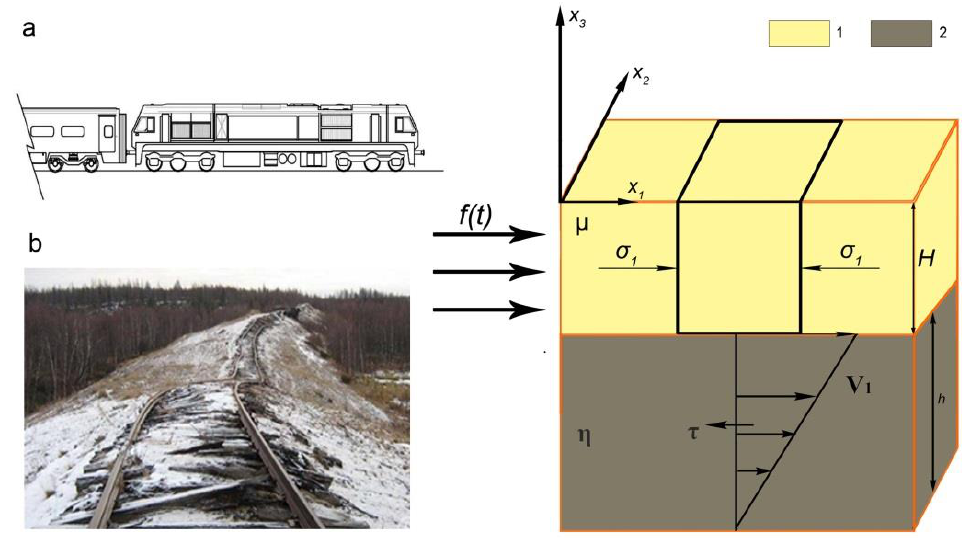
Figure 5. The stress disturbances transfer created by the train in the subgrade in horizontal direction: ( a ) geometry of the subgrade-ground system and perturbation of its stress–strain by passing train, 1—subgrade, 2—ground (boulder loam); ( b ) photo of the resulting effect on the railway (Railway track and track facilities. Available online: https://rzd-puteetz.ru/deformatsiya-osnovnoj-ploshhadki (accessed on 10 December 2021)).